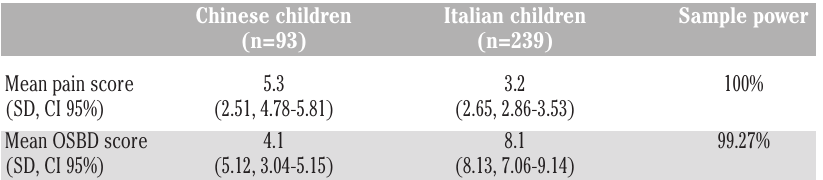
Table 2. Differences in the mean pain and Observational Scale of Behavioral Distress (OSBD) scores of Chinese and Italian children